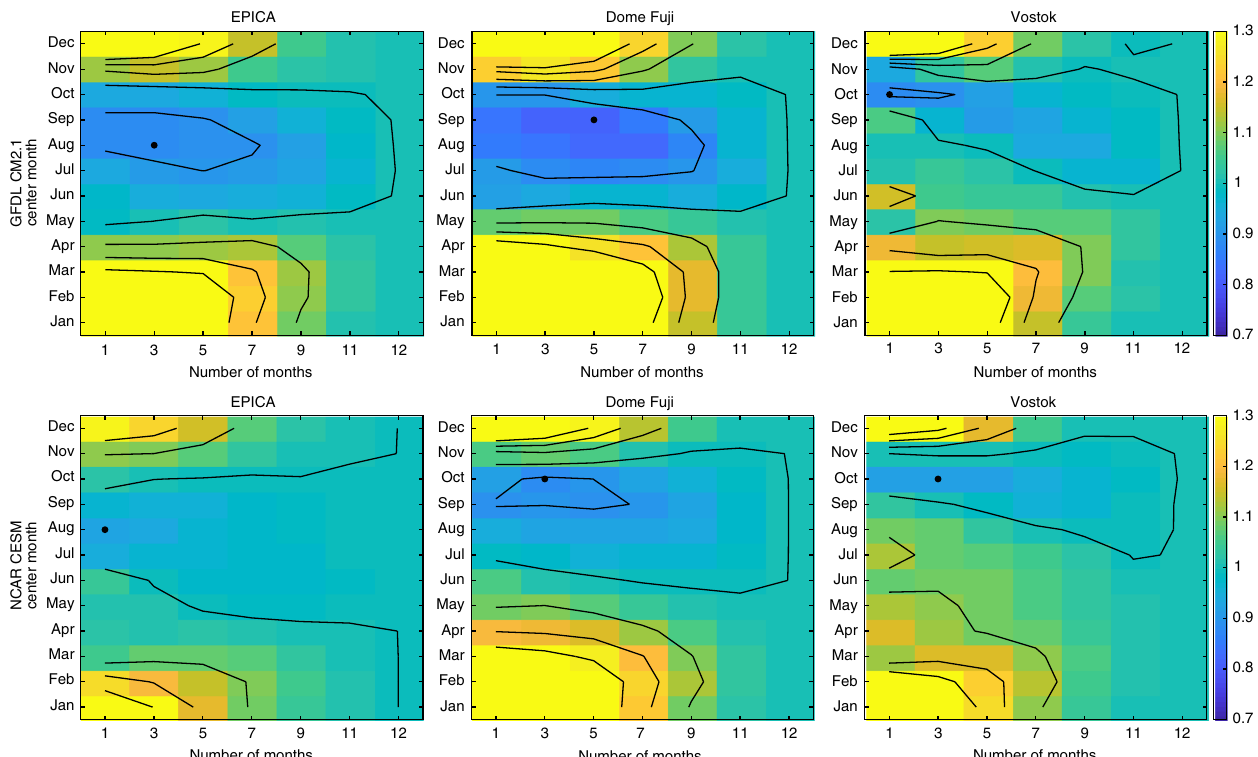
Fig. 4 Mismatch between ice cores and linear reconstructions using different monthly averages. Relative mismatch between proxy temperature records and linear reconstructions using different monthly averages. Each grid box corresponds to the mismatch for a linear reconstruction averaged over a portion of the year. The y -axis de fi nes the central month of the mean and the x -axis de fi nes the number of months included in the mean. The rightmost column (labeled 12) indicates a 12-month mean. Values are the root mean square error (RMSE) of each monthly mean case normalized by the RMSE of the annual mean case, so monthly mean reconstructions which better match the proxy record compared to the annual mean case have values <1. Contours are drawn from 0.7 to 1.3 with a contour interval of 0.1. The black dot indicates the lowest RMSE. As an example of how to interpret this fi gure, the lowest RMSE in the top center panel corresponds to a 5-month average centered on September — in other words July to November. The calculation is done for all three Antarctic locations (EPICA Dome C, Dome Fuji, and Vostok) for (top) CM2.1 and (bottom)